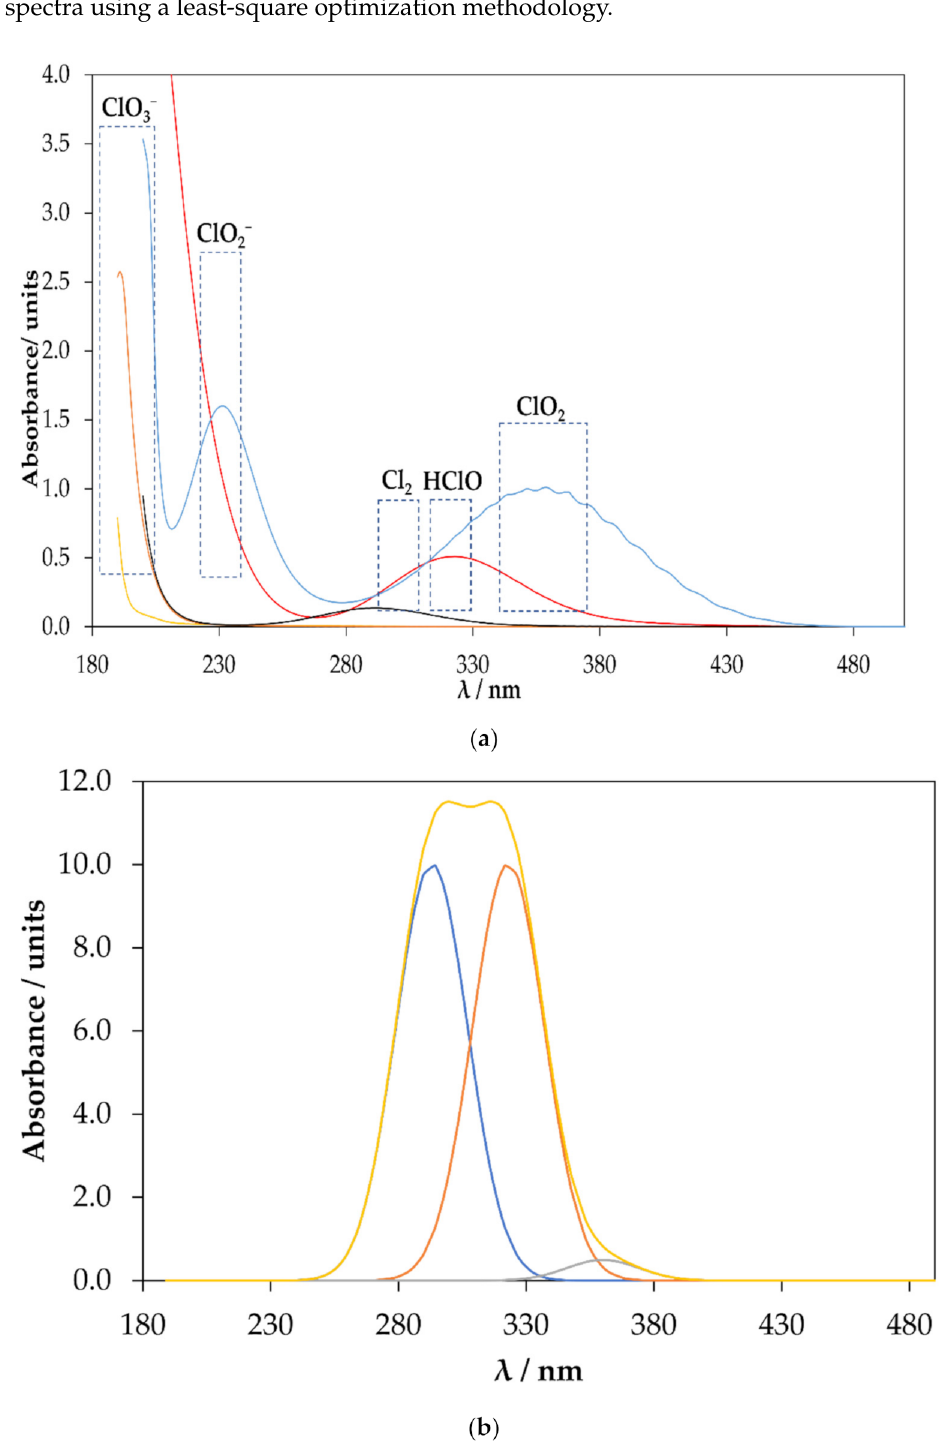
Figure 1. UV-vis spectra ( a ) and deconvoluted UV-vis spectra lines ( b ) of samples containing H 2 SO 4 5 M ( 25AC ), ClO 3 − 4.7 mM ( ▬ ), HClO 6.7 mM ( ▬ ), ClO − 5.4 mM ( ▬ ), chlorite 1.5 mM ( ▬ ).